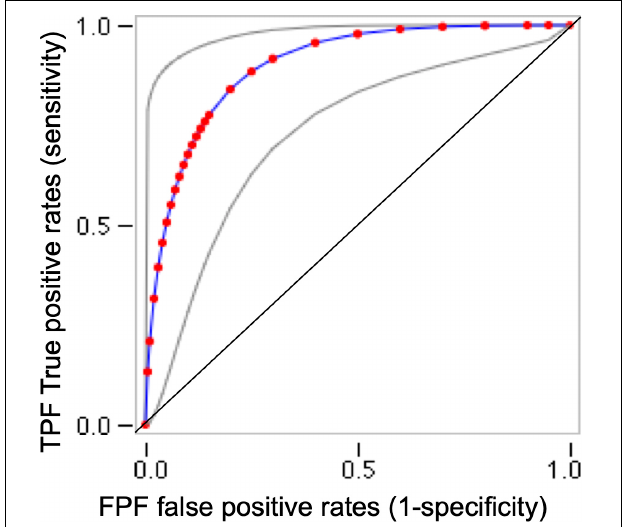
FIGURE 5 | Receiver operating characteristic (ROC) binormal curve for CARE and Haizea-Llevant classification for the total sample ( n = 52). This ROC curves plot use web-based calculator for ROC curves (http://www.jrocfit.org). Gray lines indicate 95% confidence interval of the fitted ROC curve. ROC analysis plot for each possible cut-off points of the relevant CARE scale, the true-positive proportion (sensitivity = 95%) against the false-positive proportion (1– specificity). A perfect test would have an area under the curve (AUC) of 1 and the curve would pass through the upper left corner of the plot (100% sensitivity, 100% specificity). In this study, Trapezoidal (Wilcoxon) area/AUC = 0.89 ( SE = 0.04) and the Area under the fitted curve ( Az ) = 0.90 ( SE =